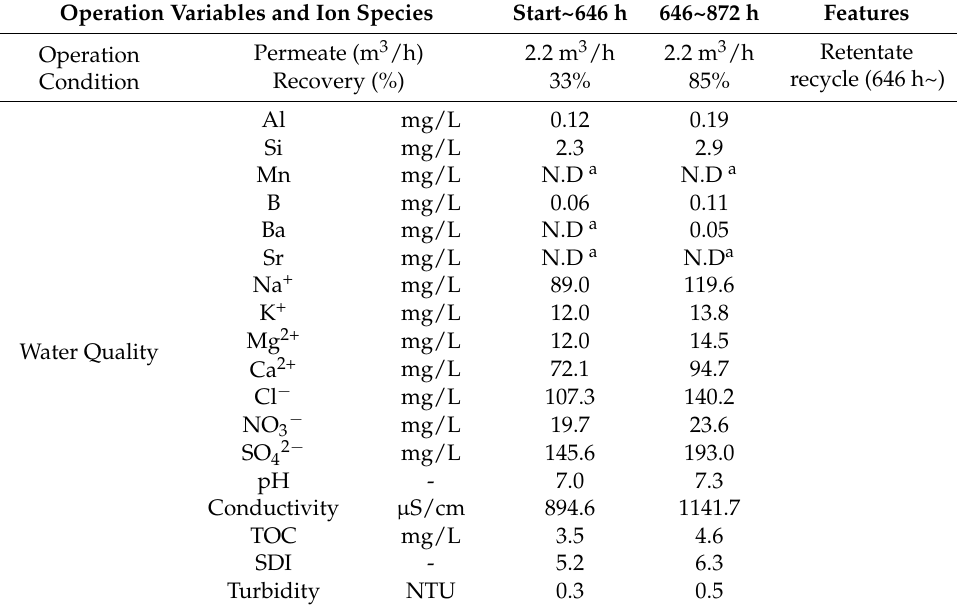
Table 4. Description of feed water quality and operation